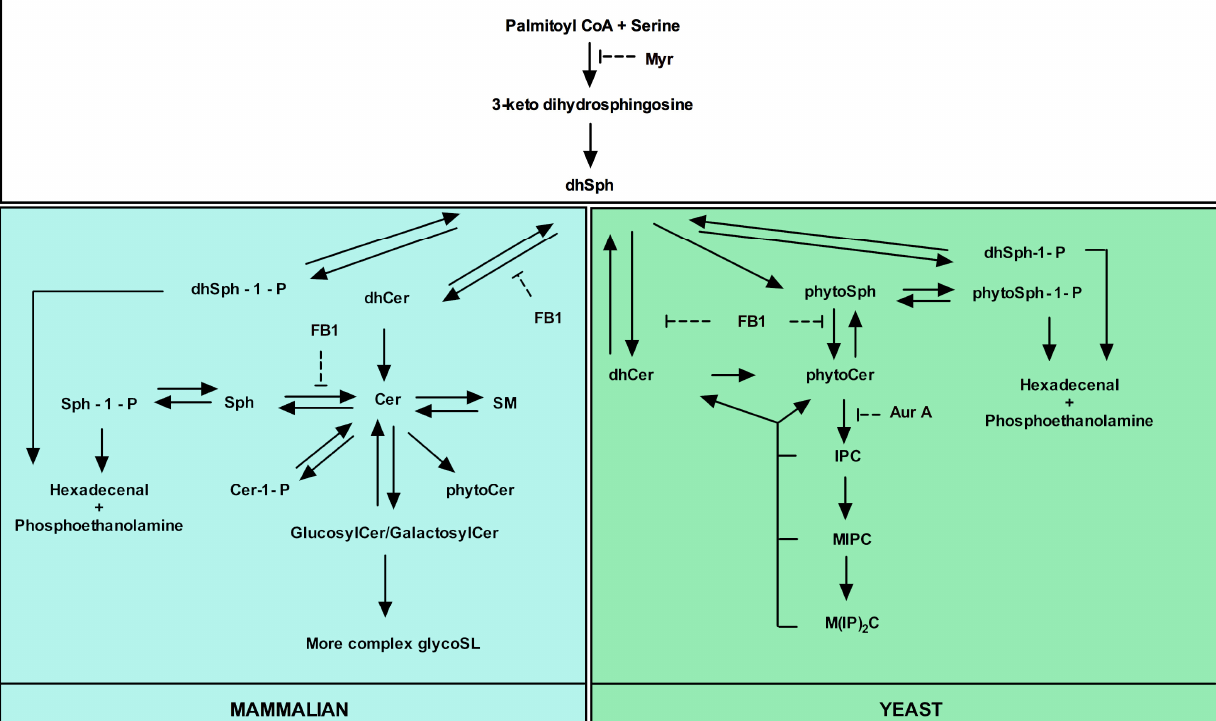
FIGURE 1: Major yeast and mammalian SL metabolic pathways. Both overlapping parts (white square) and yeast- (green square) and mam- malian (blue square)-specific processes are indicated as well as the targets of commonly used inhibitors of SL biosynthesis. Adapted from